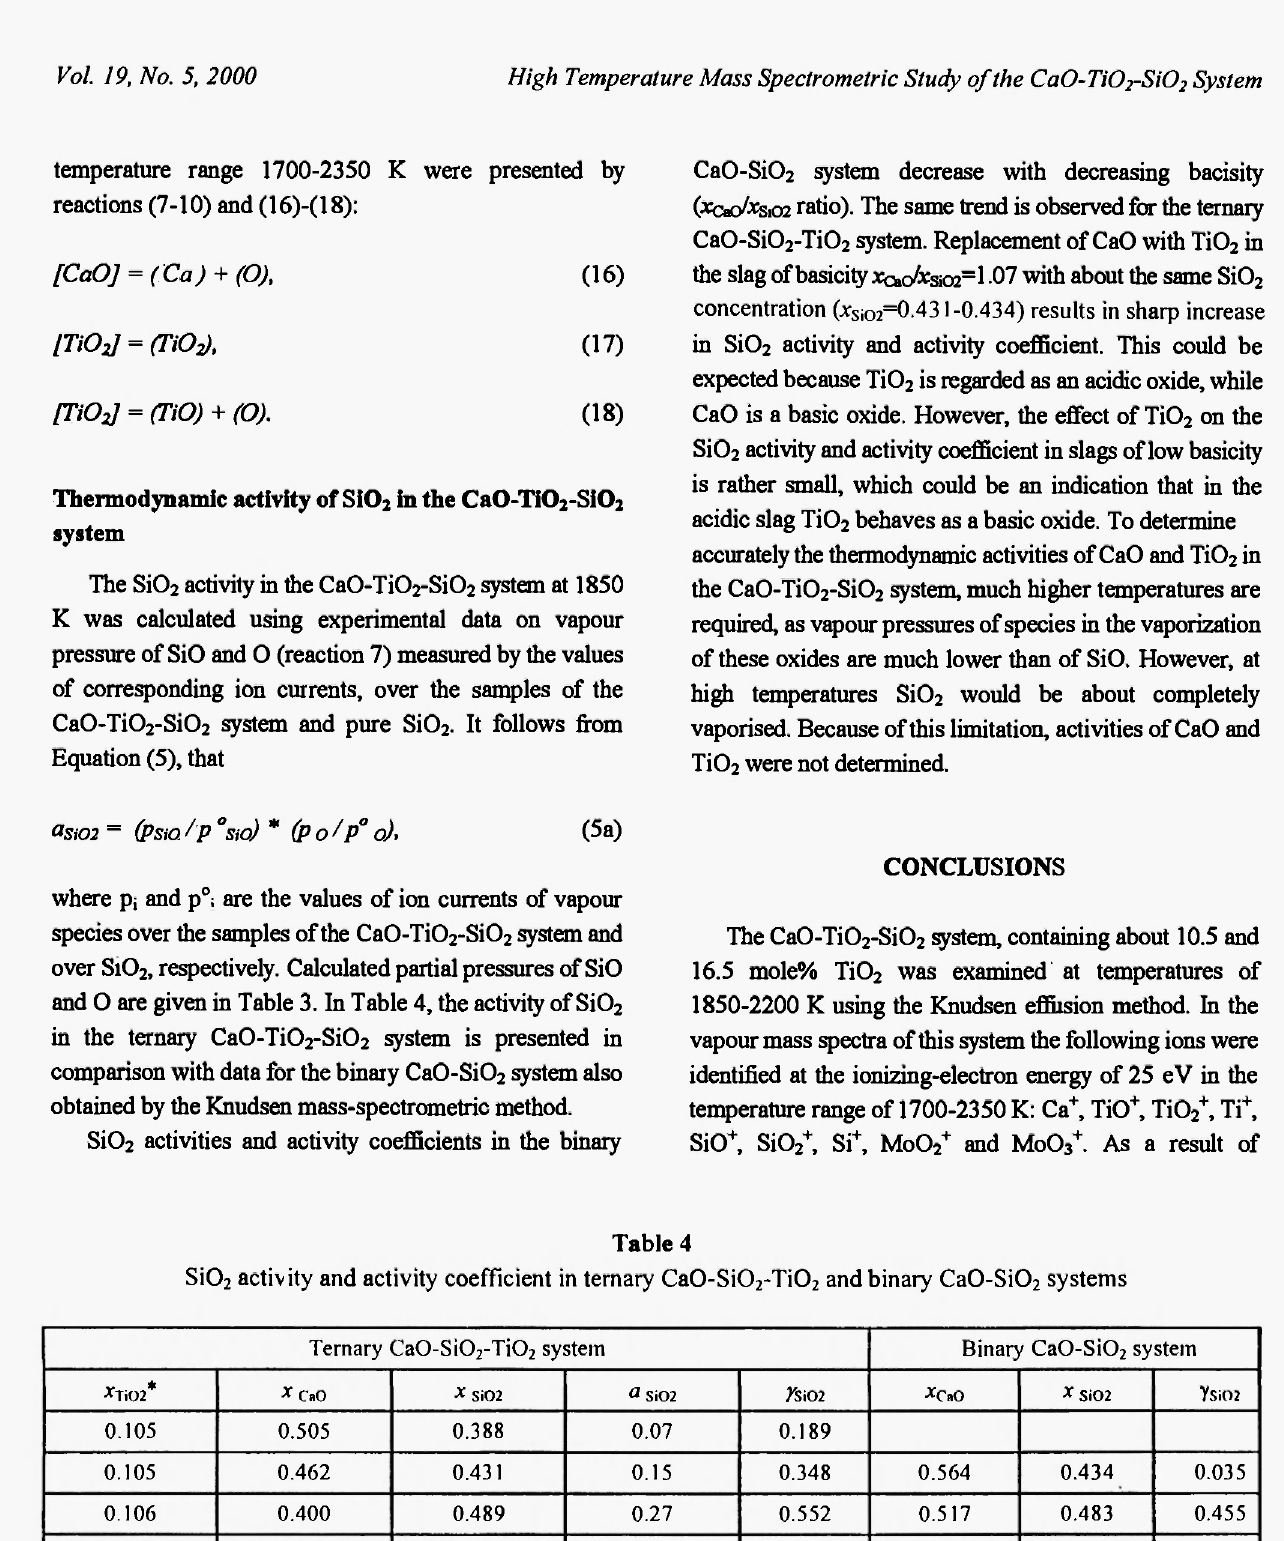
Si0 activity and activity coefficient in ternary Ca0-Si0 2 Ternary Ca0-Si0 2 -Ti0 2